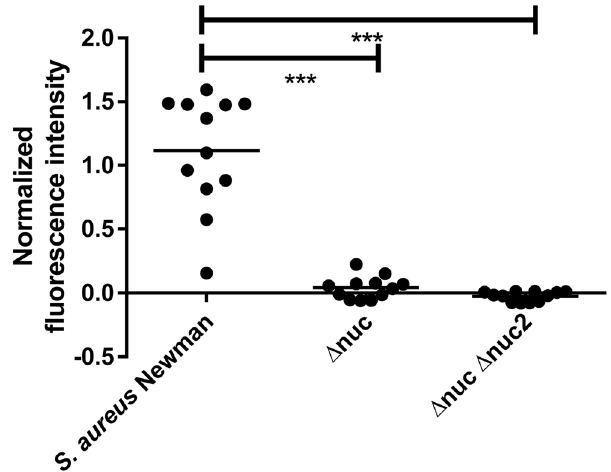
Figure 1. P2&3 TT-probe activation by S . aureus Newman (Newman), S . aureus Newman Δ nuc ( Δ nuc) and S . aureus Newman Δ nuc , Δ nuc2 ( Δ nuc, Δ nuc2). The horizontal line represents the mean. *** Indicates P < 0.0001.